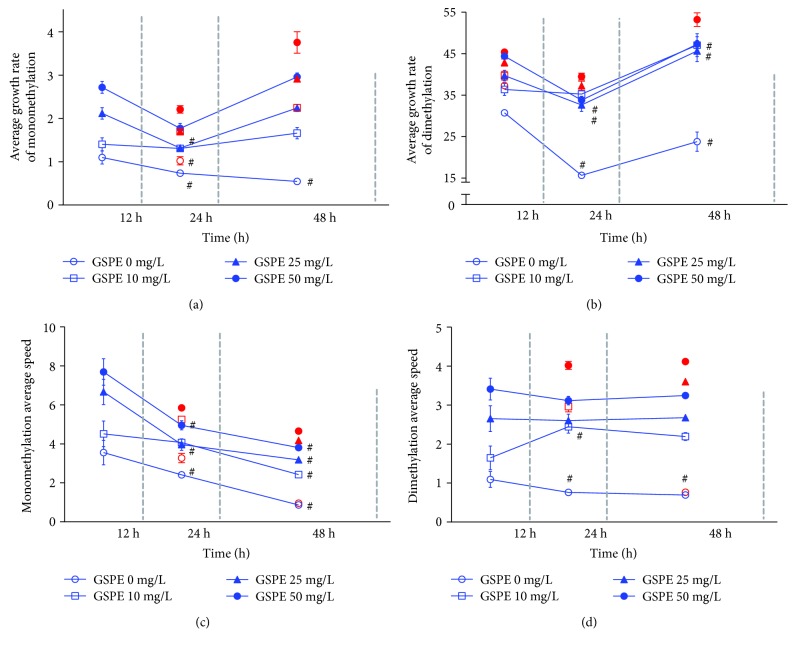
Effects of grape seed procyanidin extract on average growth rate of methylation and average methylation speed in Nrf2-suppressed cells (mean ± SD, n = 3). Nrf2-suppressed cells were treated with arsenic (25 μM) and grape seed procyanidin extract (GSPE; 0, 10, 25, and 50 mg/L) for 24 h. #Versus 0–12 h group, P < 0.05; red shapes indicate the level in Nrf2 normal cells versus the same intervention group in Nrf2-suppressed cells, P < 0.05.